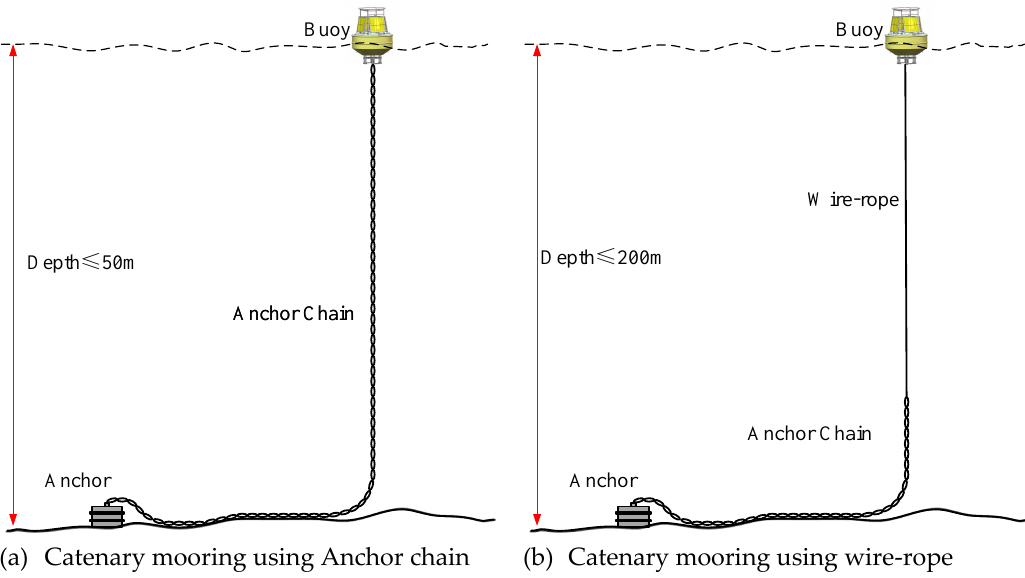
Figure 1. Catenary mooring.